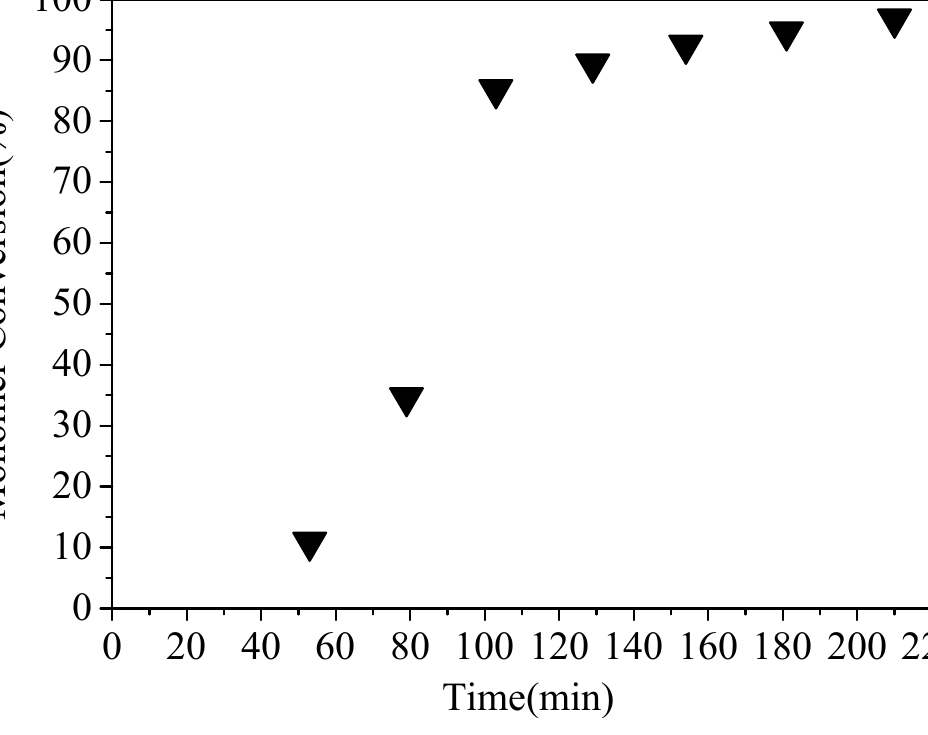
Figure 5. Evolution of monomer conversion versus time for RITP emulsion copolymerization. Conditions: m (PEGMA)/ m (MAA) = 1/1 and 1/2; m (MAA) + m (PEGMA) = 1.664 g; m (BA)/m(St) = 1/2; n (St)/ n (HEMA)/ n (BMA)/ n (BA)/ n (ACPA)/ n (I 2 ) = 18.36/18.74/40.36/7.46/1.15/1, ammonia solution (0.70 g); m (I 2 ) = 0.273 g; m (ACPA) = 0.346 g; no MMA in the polymerization system; the total mass of ingredients without ACPA Solution and I 2 was maintained at 30.08 g in theory; the reaction time was 210 min.